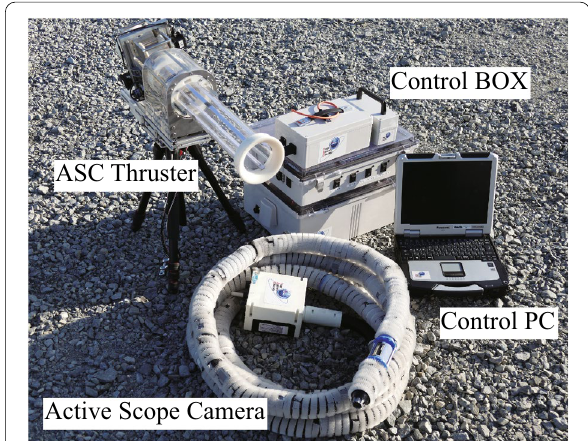
Fig. 12 Photograph of the system used in the search experiment. The system consisted of the developed robot, control box for operating the robot, robotic thruster for insertion, and control PC. In addition, four other PCs were used: one for sensor acquisition and three for the elemental technology for information collection described below